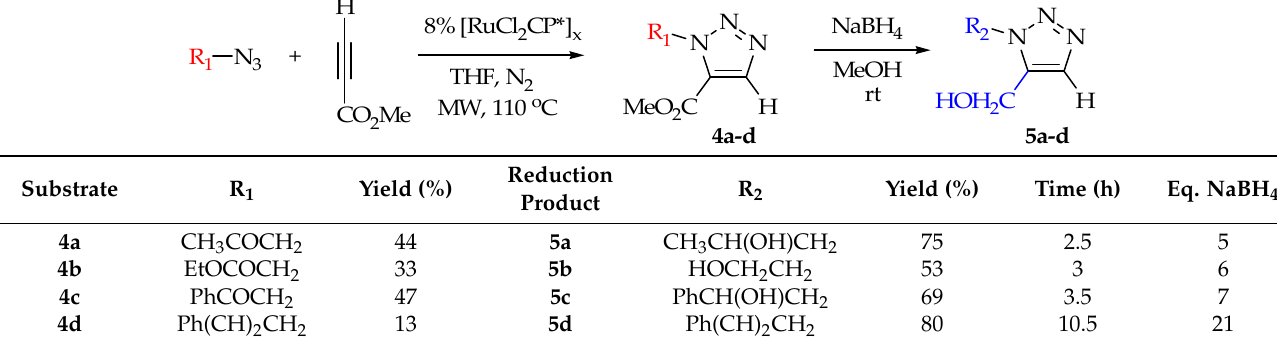
Table 3. The reduction of 6a – d with NaBH 4 in methanol afforded 7a – b and 8c – d . It was